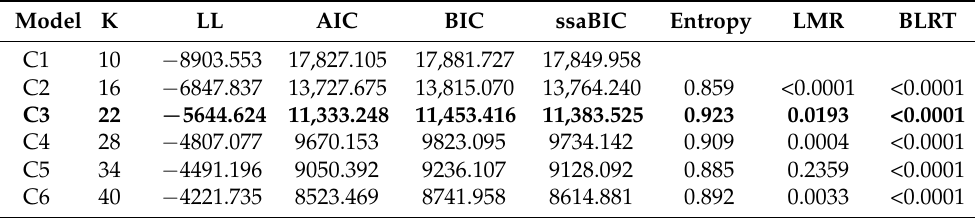
Table 2. Fit statistics of latent classes of PERMA (n = 1741).